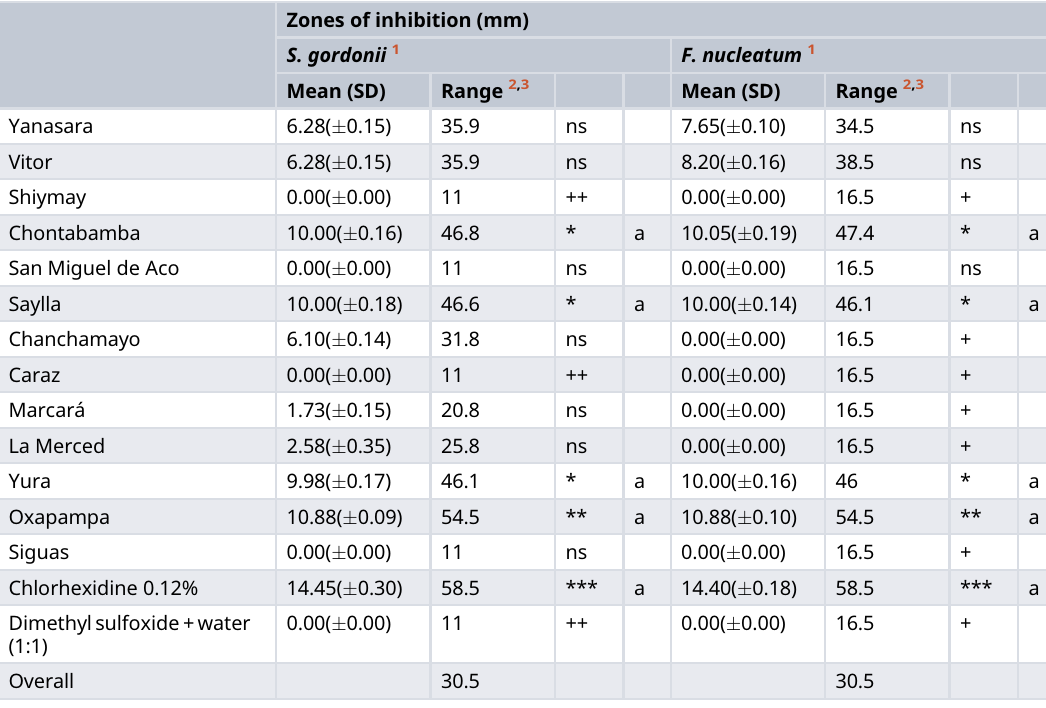
midrange; ns: not significant. 3 Dunn test for multiple comparisons, where the same letter indicates no difference between treatments exceeding the average.